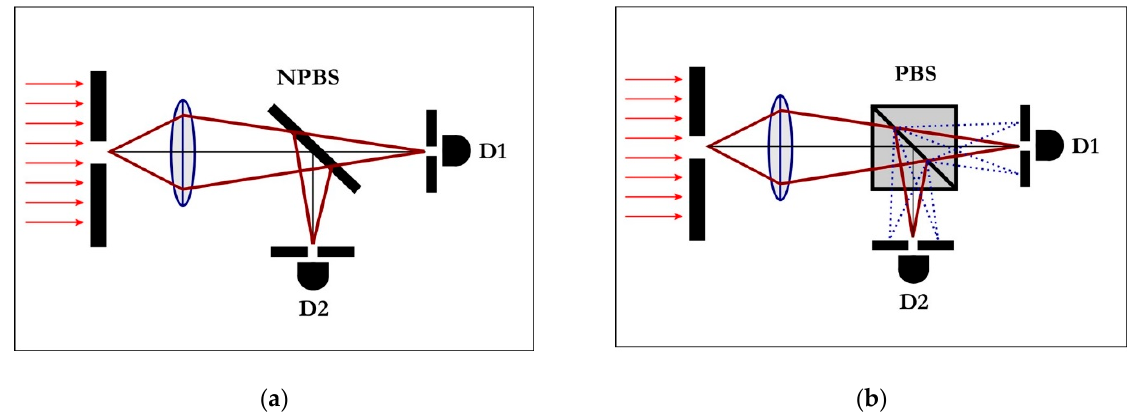
Figure 1. Spatial filtering of polarization components in optical arrangements. Input modes of polarization can suffer differential phase-shifts during propagation through birefringent media. If the axis of polarization of a component is neither parallel to the fast axis nor to the slow axis of a polarizing beam-splitter, it will suffer a phase shift relative to the rest of the projection. As a result, a single spatial mode at the input can be transformed into a projection with several spatial modes at the output, if it is not polarized. These modes can be resolved in the focal plane of a lens, in which case input polarization information is converted into output spatial information. ( a ) Optical modes are not perturbed by ideal non-polarizing beam-splitters (NPBS), such as half-silvered mirrors. Component states of polarization cannot be spatially resolved. ( b ) A single optical mode is transformed into multiple optical modes after passing through a polarizing beam-splitter (PBS). Individual modes can be isolated in the focal plane with a pinhole (or, even better, with the tip of a single-mode optical fiber). The input state of polarization is erased by the birefringent medium, but the relative magnitude of the corresponding spatial mode can be measured and used for post-processing.